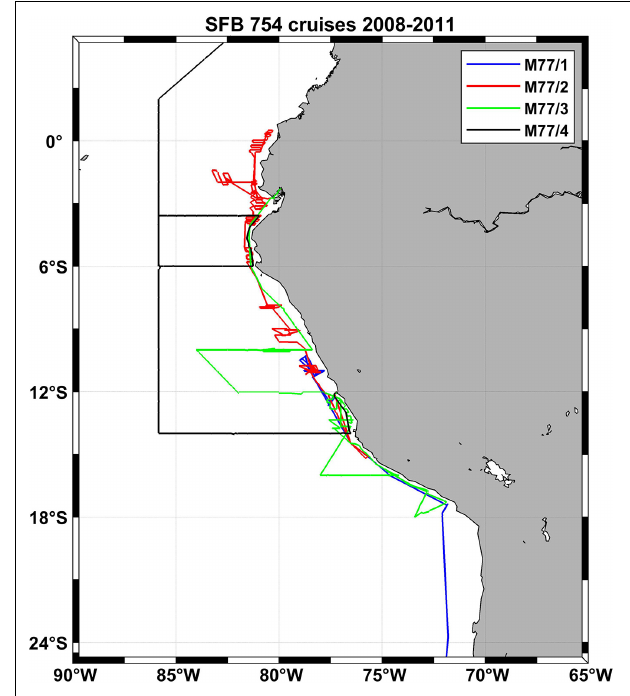
FIGURE 5 | Cruise tracks of four SFB 754 cruises in the Pacific in the first funding period of the project